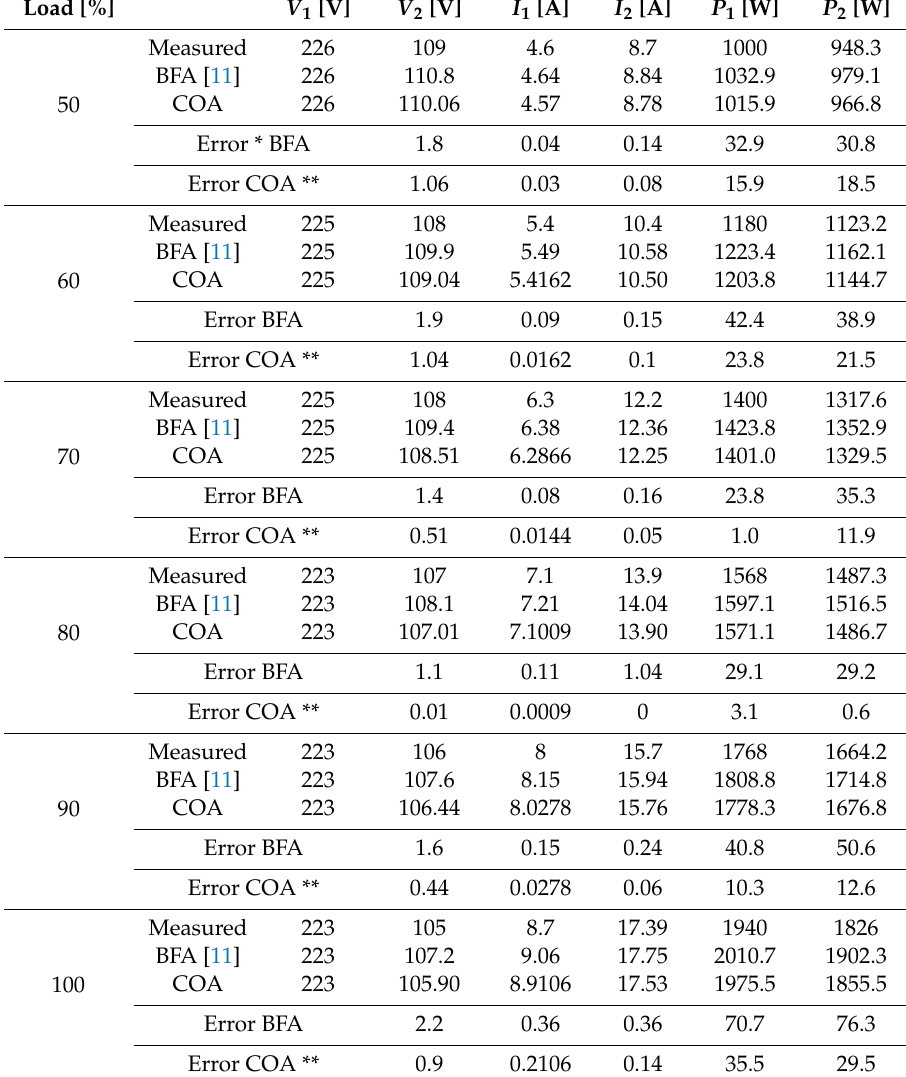
Table 6. Measured and estimated values for a single-phase transformer